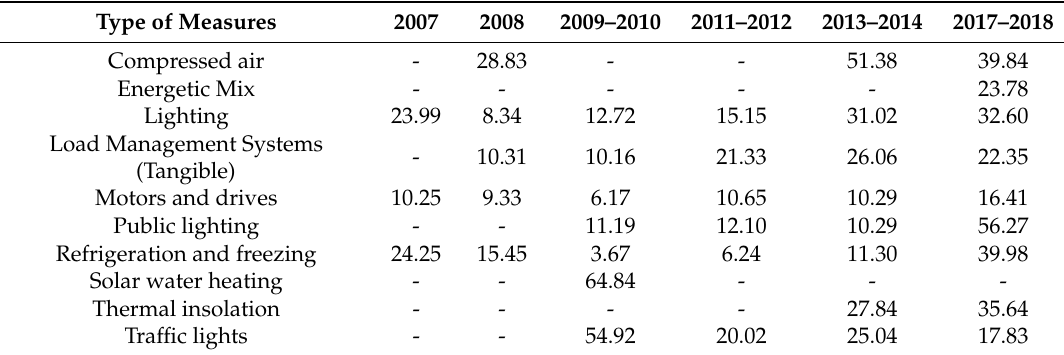
Table 5. Average Societal costs of each avoided MWh of the selected measures in each PPEC edition (in € /MWh)